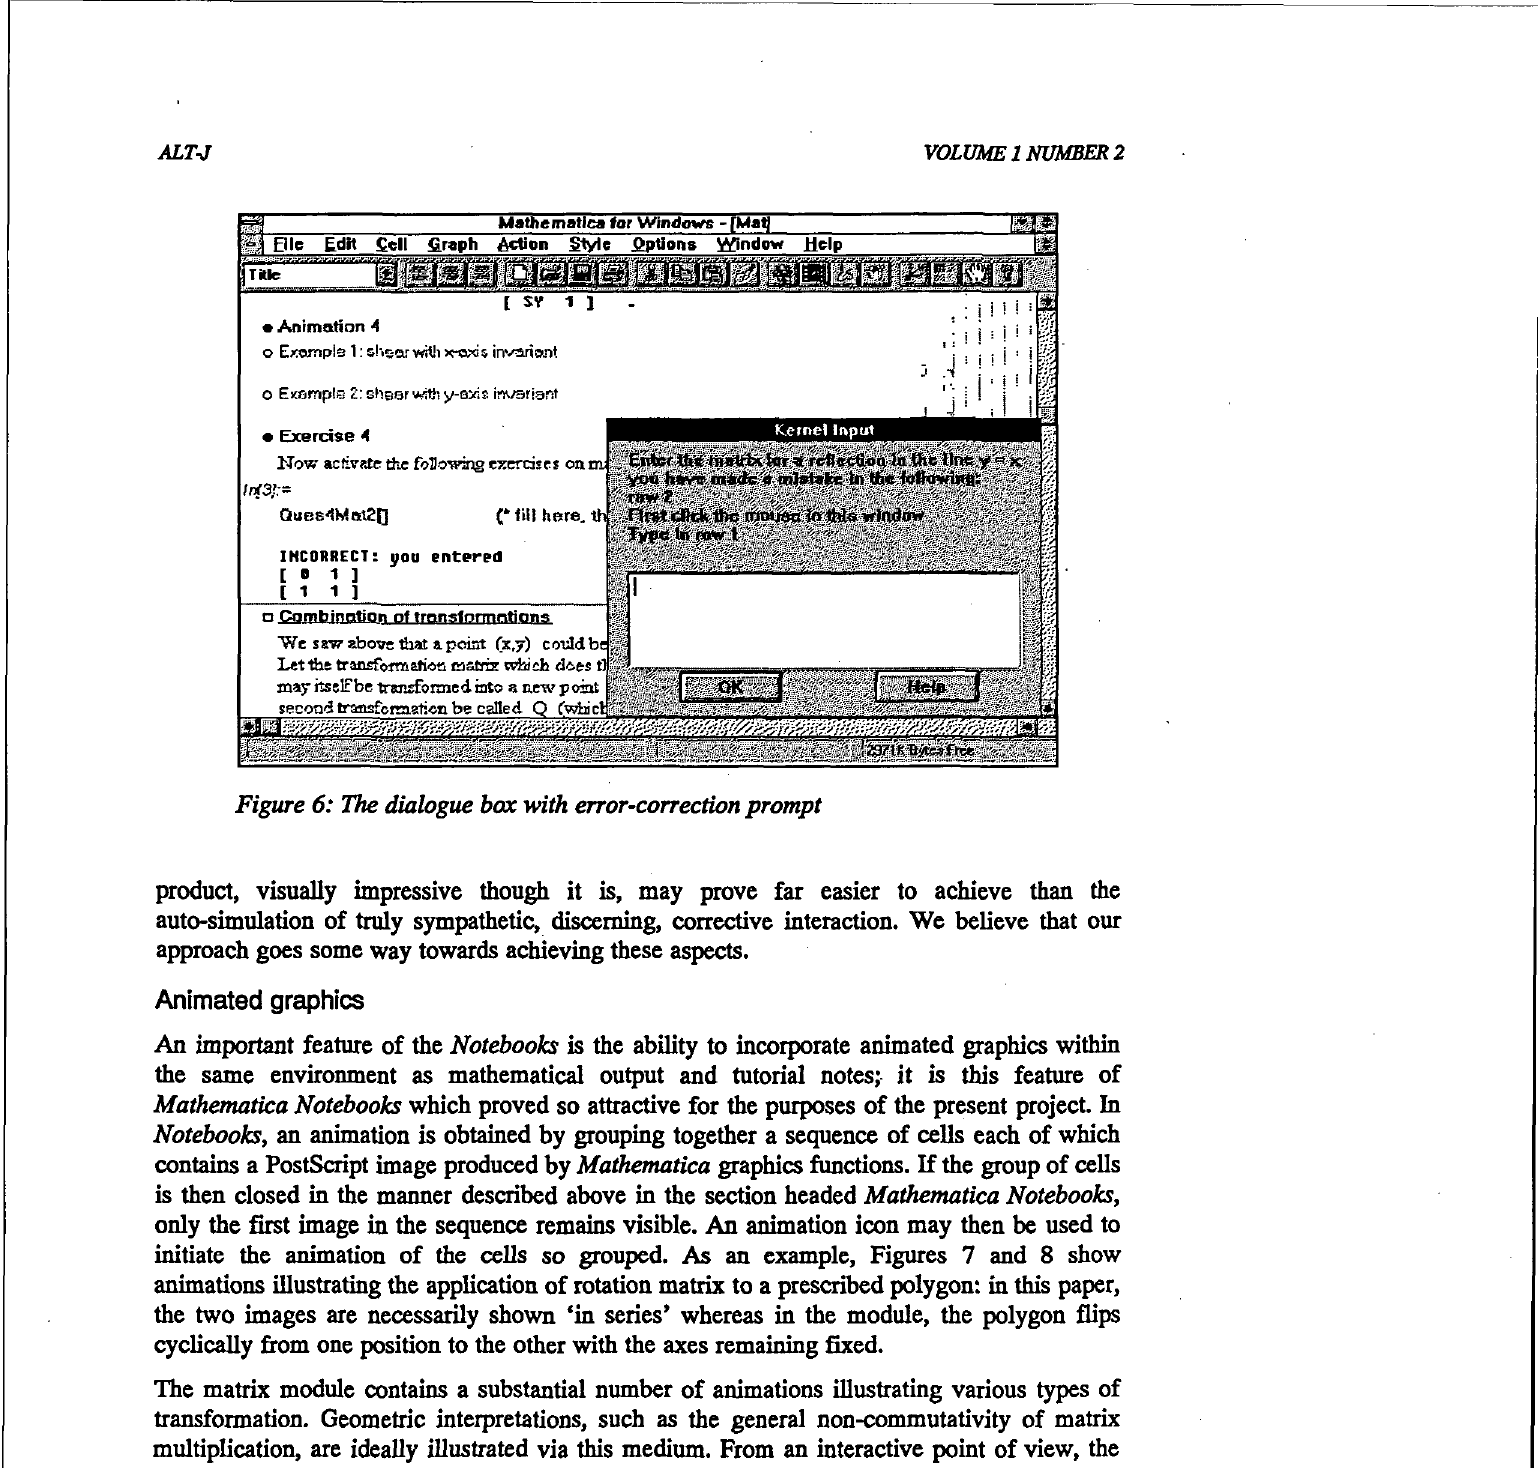
Figure 6: The dialogue box with error-correction prompt product, visually impressive though it is, may prove far easier to achieve than the auto-simulation of truly sympathetic, discerning, corrective interaction. We believe that our approach goes some way towards achieving these